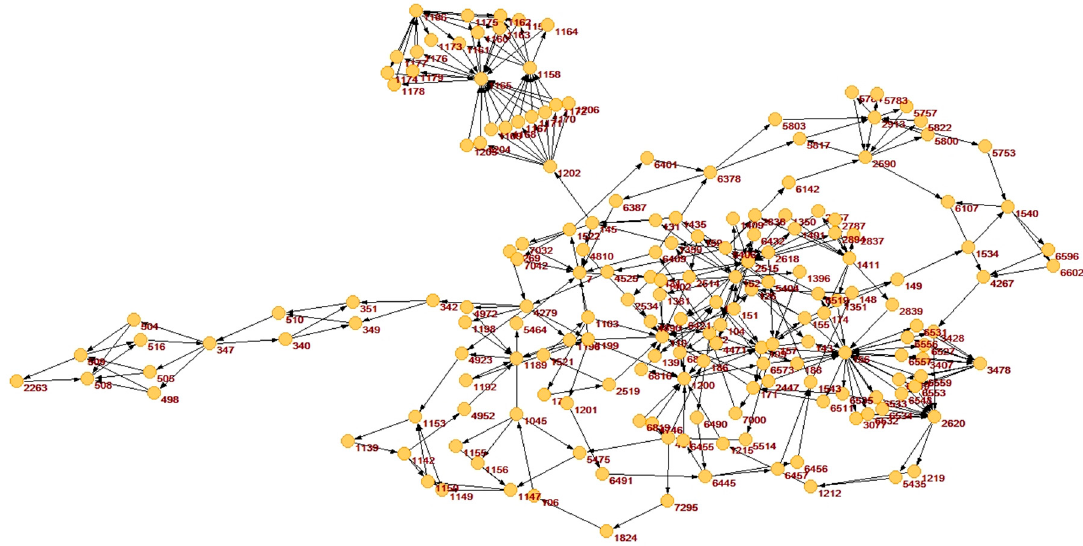
Figure 7. A real debt graph after simplification.